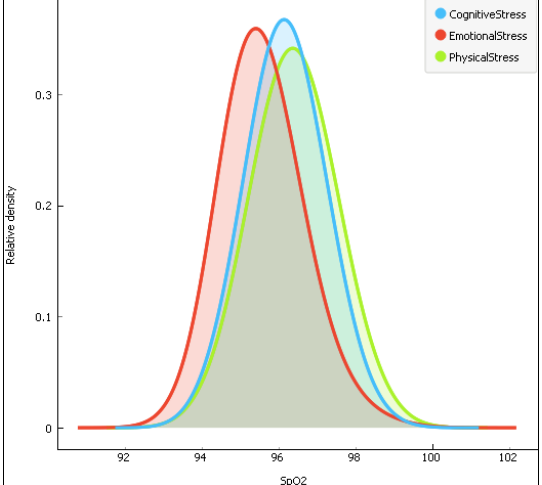
Figure 7. The distribution of the arterial oxygen saturation data (SpO2) according to the three stress types.